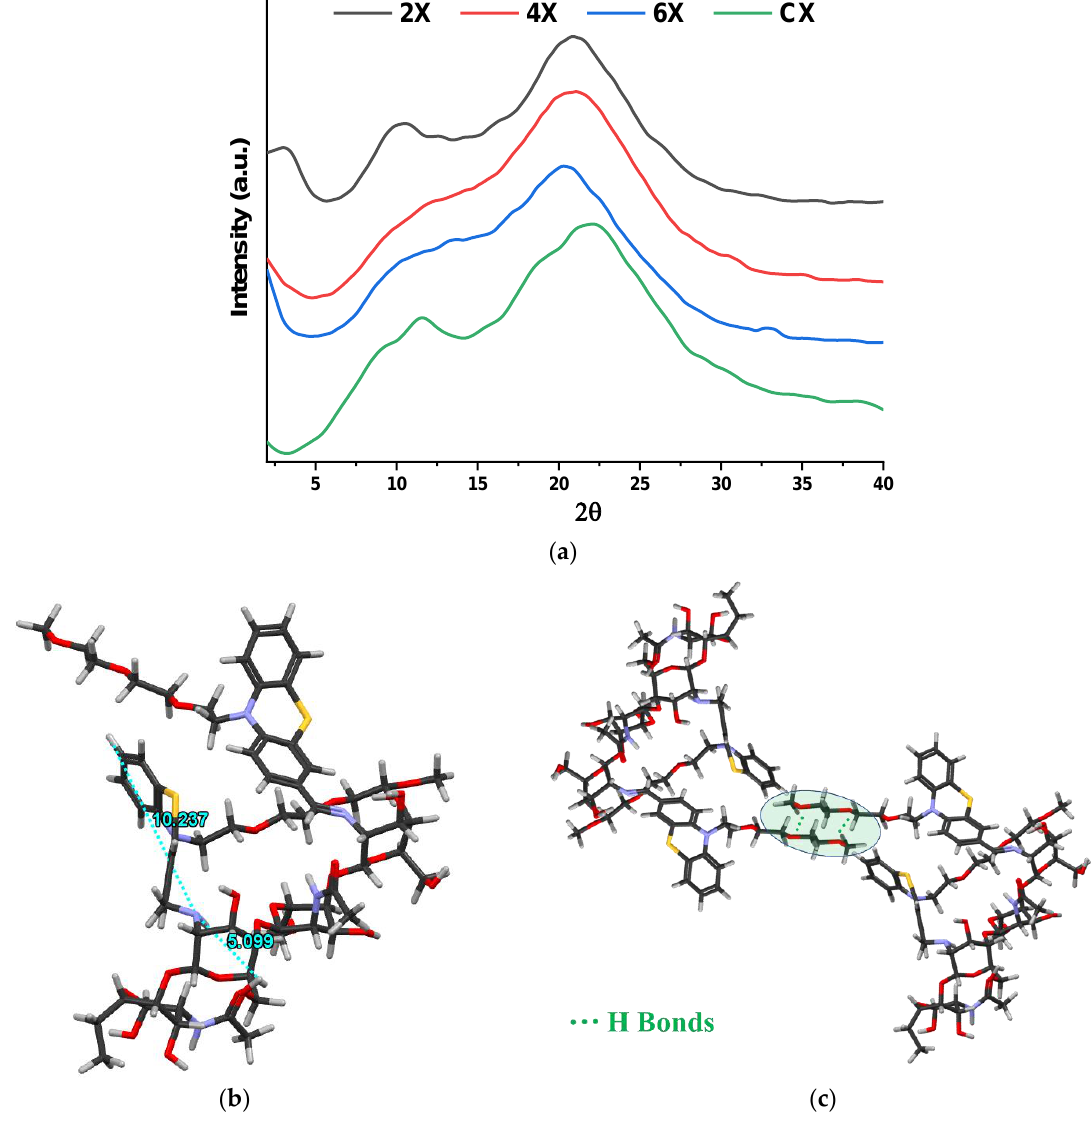
Figure 3. ( a ) X-ray diffractograms of the xerogels and ( b , c ) simulation of the layered architecture by HyperChem Professional 8.0 software.